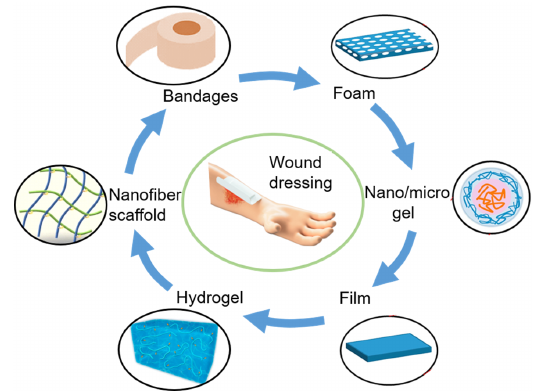
Figure 2. Structure of different wound